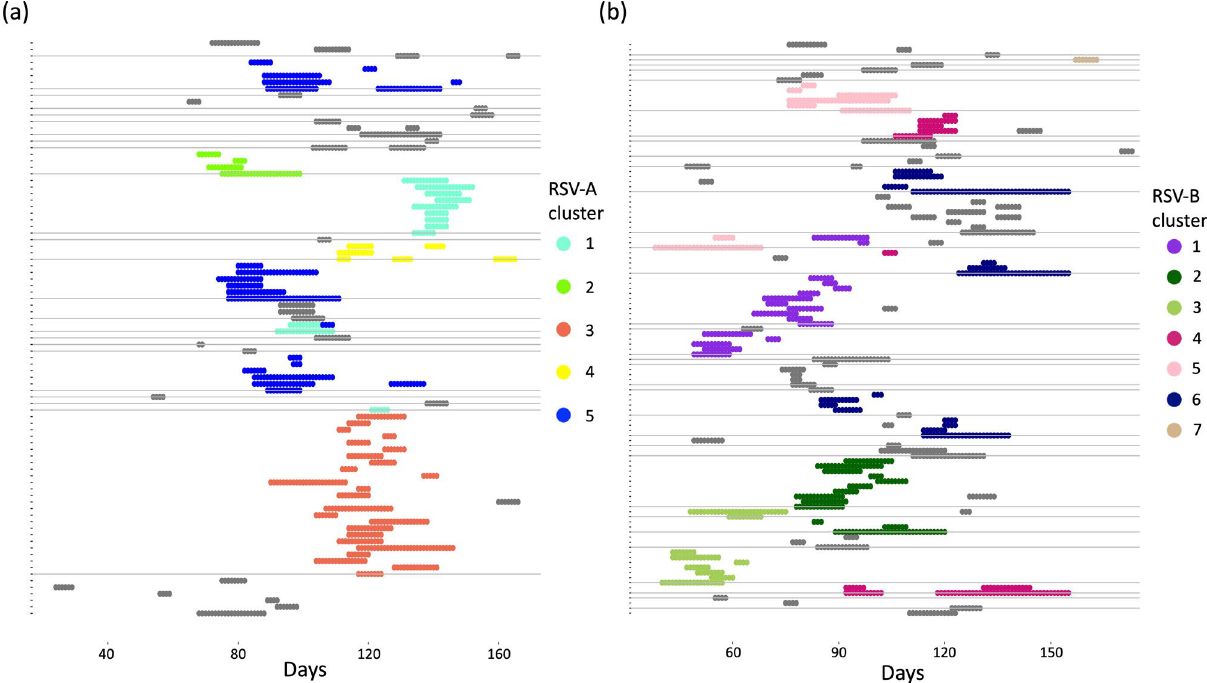
Figure 1. Shedding patterns for RSV-A, panel ( a ), and RSV-B, panel ( b ). Each notch on the y-axis represents a single individual and the horizontal grey lines separate the individuals into households, time in days is on the x-axis. The shaded regions show RSV shedding episode colour-coded by genetic cluster where grey represents episodes whose cluster id is unknown. This figure was generated using R programming language version 4.0.3 46